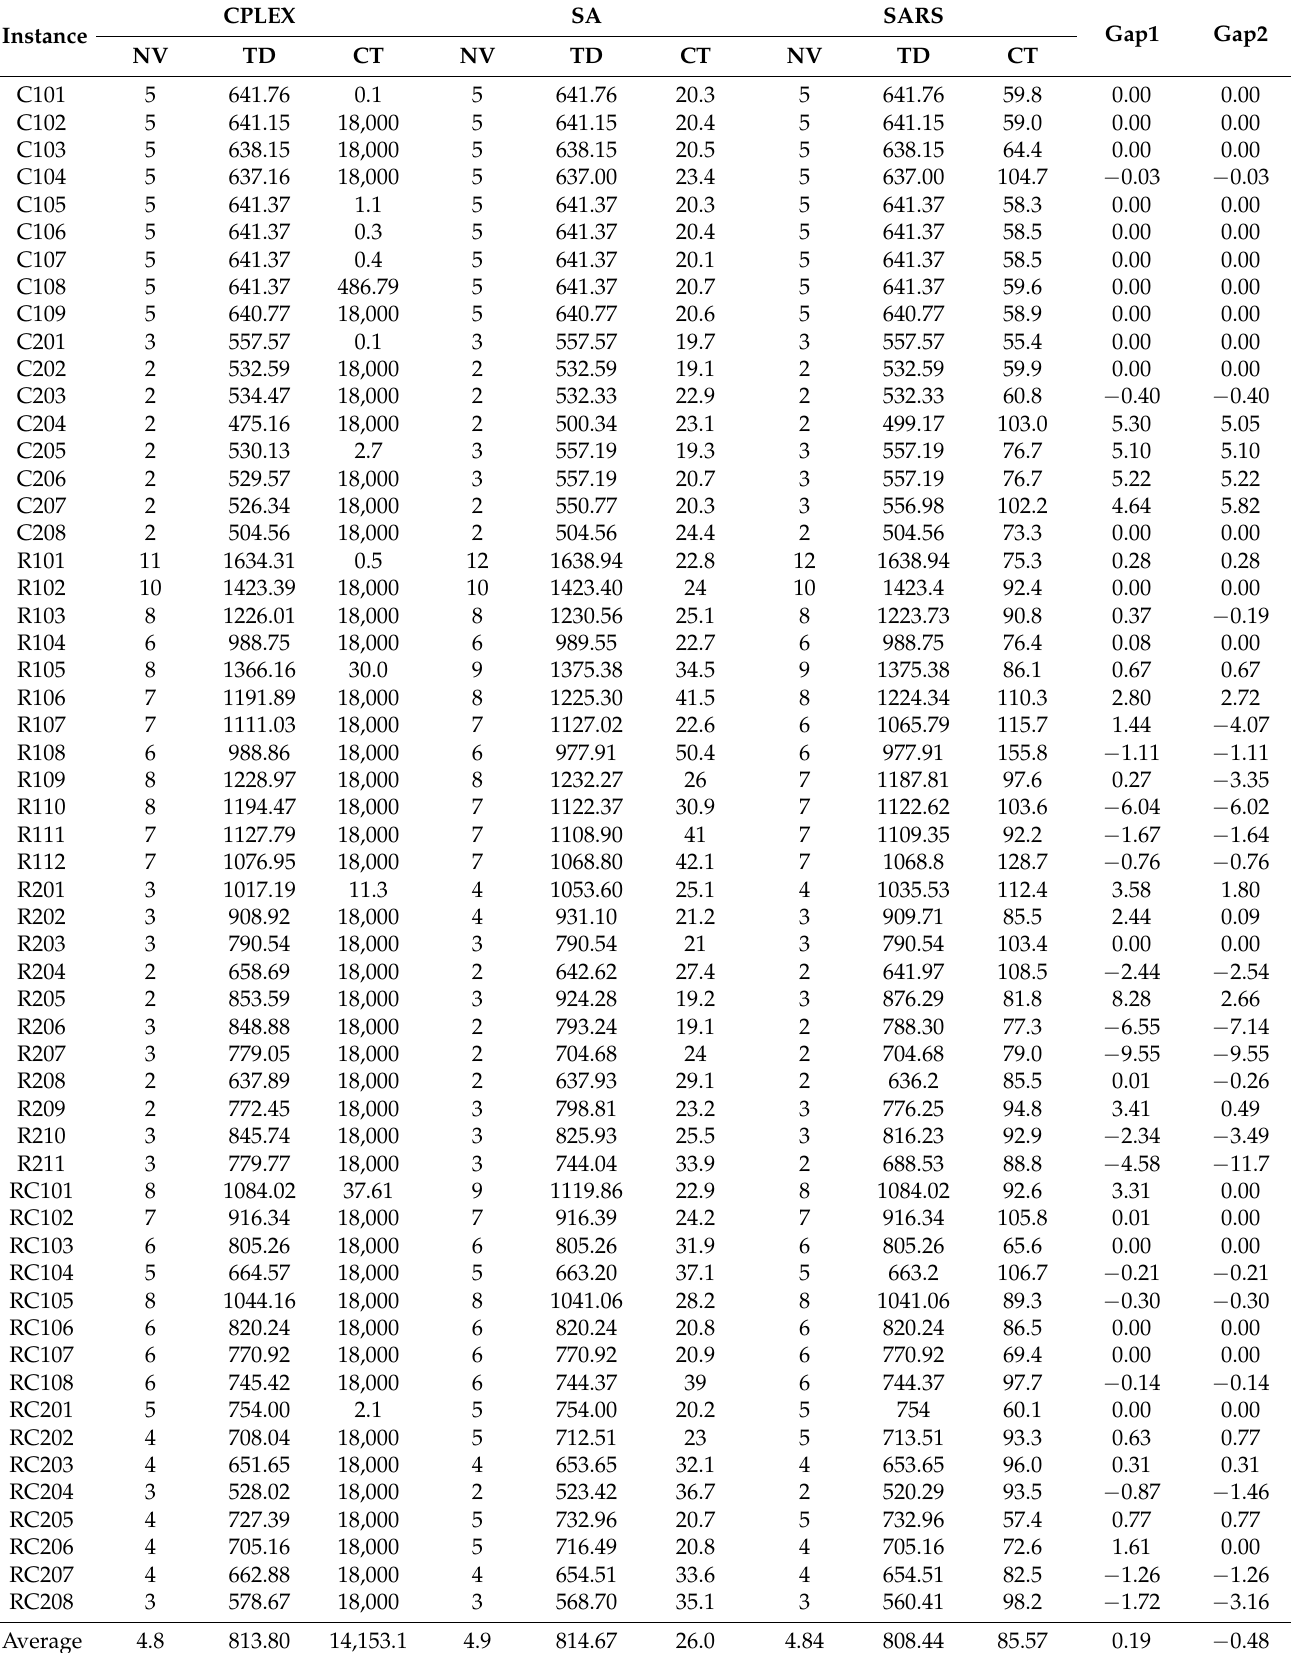
Table 9. Comparison among CPLEX, SA, and SARS on the PCPTW dataset with 50